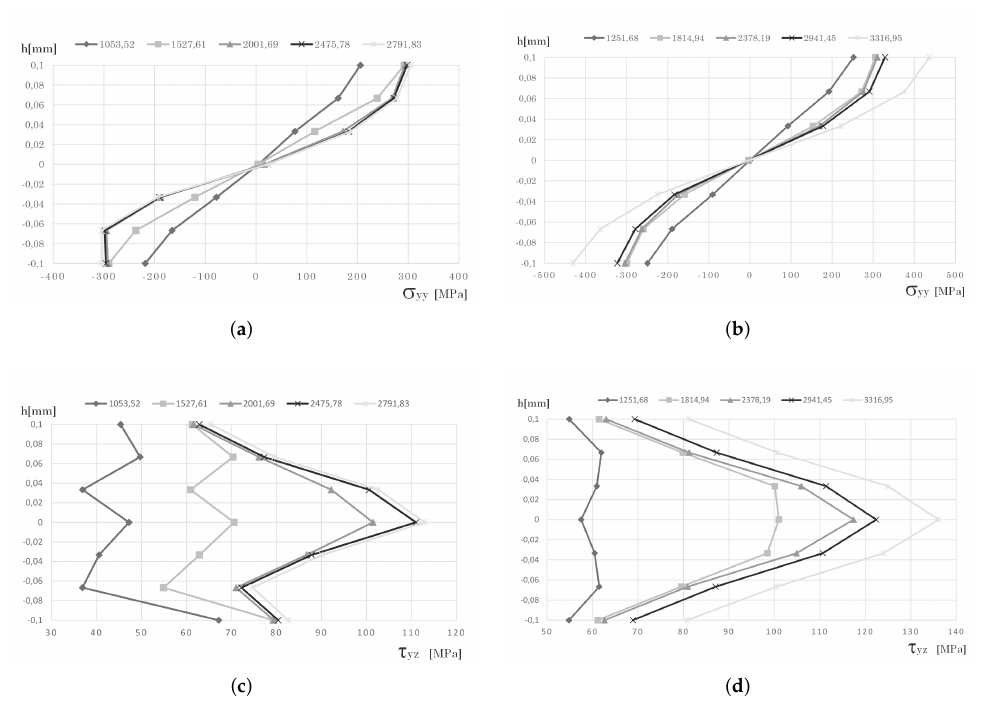
Figure 7. Stress distribution along the thickness in line B-B’ for the clamped. FEM analysis ( a ) σ yy and ( c ) τ yz . RPIM analysis ( b ) σ yy and ( d ) τ yz . Load increments in [kN/m 2 ].